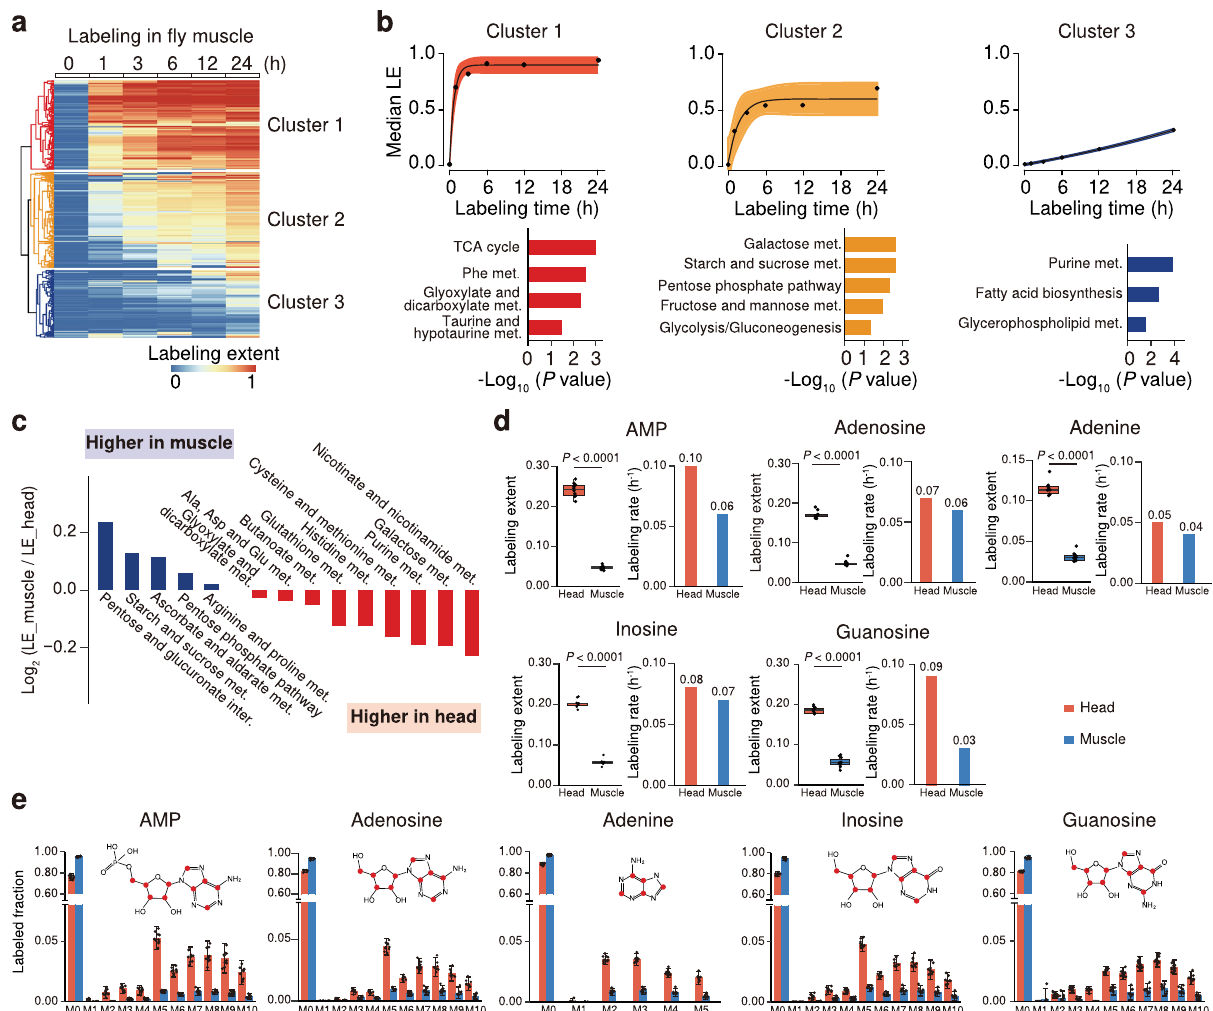
Fig. 3 Quantitative stable-isotope tracing reveals distinct metabolic pro fi les in different tissues. a Hierarchical-clustering analysis of labeled metabolites in Drosophila muscle tissues ( n = 597 metabolites). b Upper panels, labeling dynamics of metabolites in each cluster; black dots represent the median labeling extent (LE) values of metabolites in the cluster in muscle tissue; black lines represent the fi tted metabolic dynamics; error bands represent 95% con fi dence intervals. Bottom panels, enriched pathways in each cluster ( p -values < 0.05; hypergeometric test). c Comparisons of labeling extents of 14 shared metabolic pathways in head and muscle tissues. d Labeling extents (LE) and labeling rates ( k ) of metabolites in purine metabolism ( n = 10 biological replicates per group; two-tailed Student ’ s t -test). The centerlines of the boxplots indicate the median values; the lower and upper lines in boxplots correspond to 25th and 75th quartiles, and the whiskers indicate the largest and lowest points inside the range de fi ned by 1st and 3rd quartile plus 1.5 times interquartile ranges (IQR). e Labeled fractions of metabolite isotopologues in purine metabolism. Bar plots represent mean ± SD ( n = 10 biological replicates per group). The red dots in chemical structures represent 13 C-labeled carbon atoms. Source data are provided as a Source Data fi